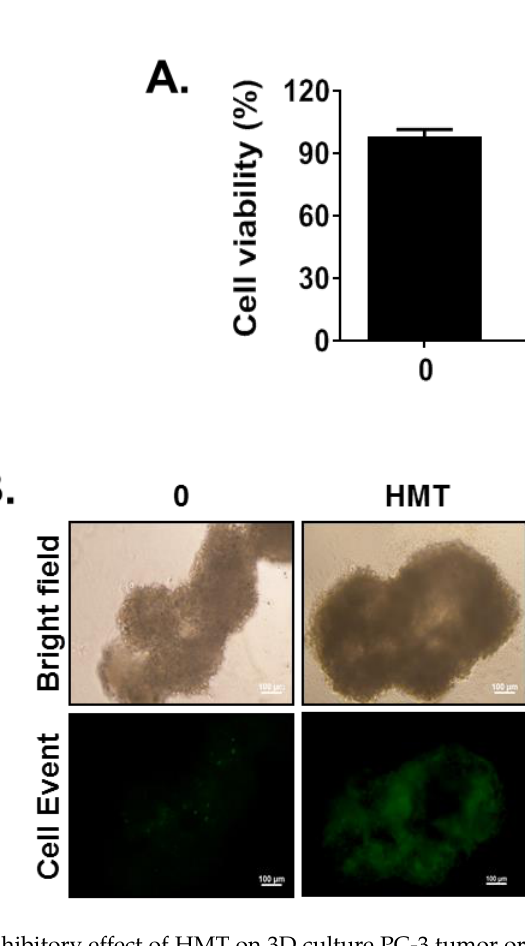
Figure 5. Inhibitory effect of HMT on 3D culture PC-3 tumor organoid growth. Five days after spheroid formation, the formed spheroids were treated with 200 μg/mL HMT for 48 h. Six organoids per group were used. ( A ) For organoid viability, the CELLOMAX viability kit was added to each well and reacted for 18 h. Data represent mean ± SD. * p < 0.05, ** p < 0.01, and *** p < 0.001 compared with control. ( B ) For apoptosis analysis, 2 μM CellEvent (Invitrogen, USA) was added to each well and reacted for 1 h. Pictures were obtained using a fluorescence microscope (Nikon, Tokyo, Japan).